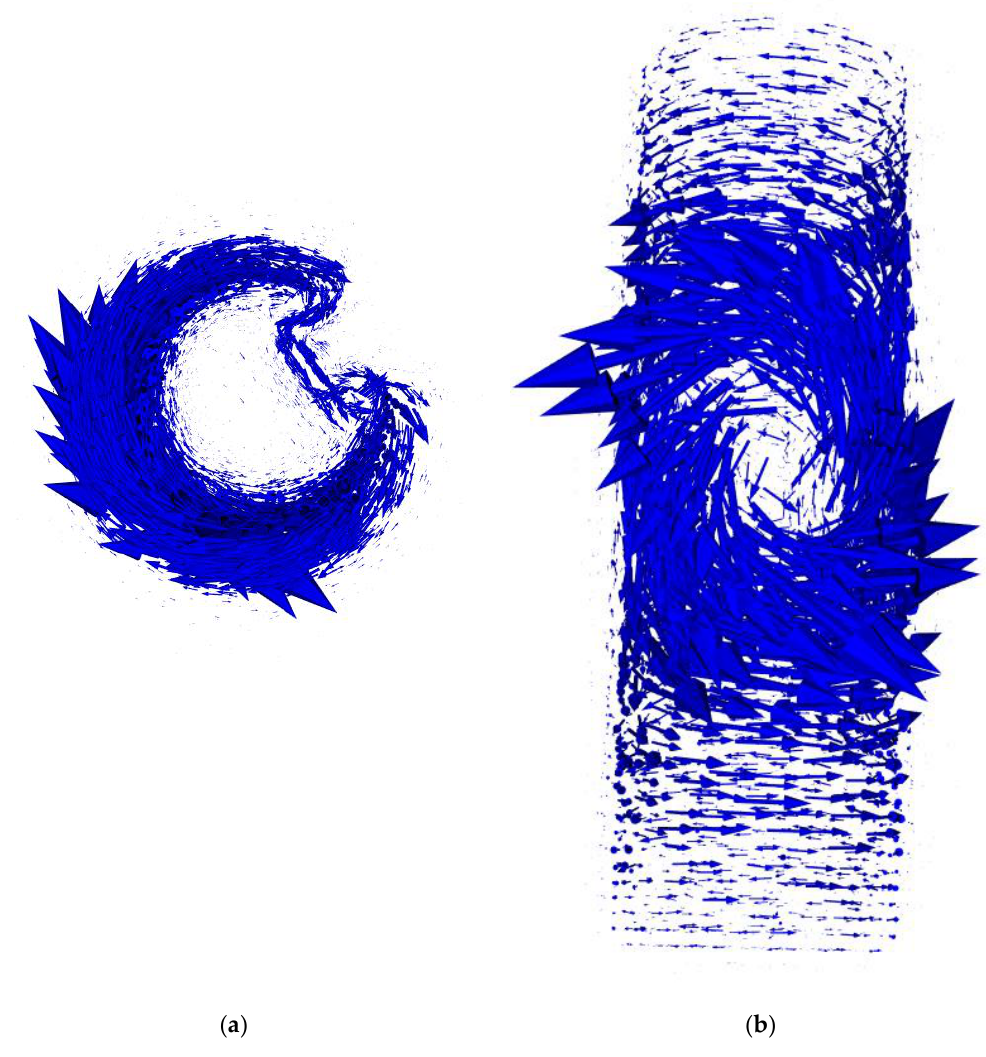
Figure 9. Exemplary distribution of vectors of induced eddy currents in the tomography setup: ( a ) top view of the tested element; ( b ) side view. All simulations were conducted in Elmer software. The length of the arrow represents the relative value of the induced current in each node. The scale for absolute values is negligible, as all final results of tomography transformation are normalized to the 0 – 1 range.